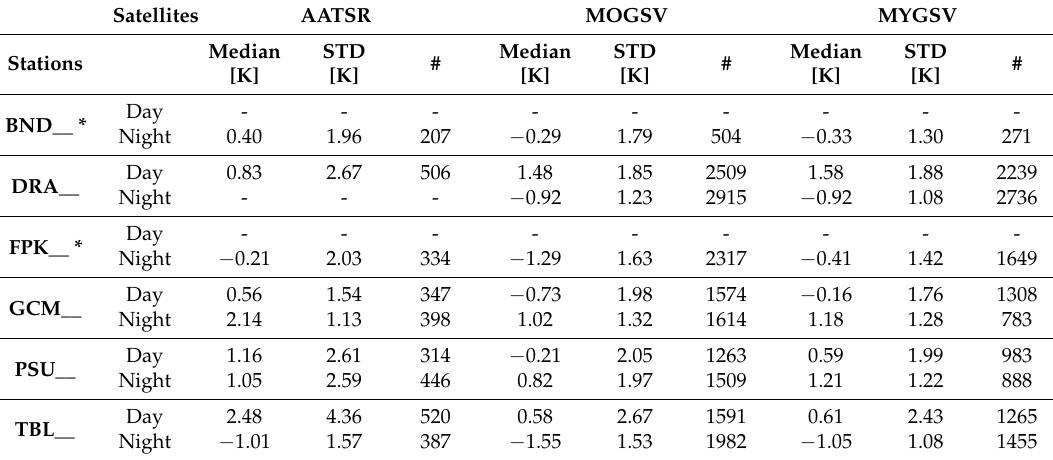
Table 5. Median validation accuracy, STD, and number of data points (#) over the SURFRAD stations for all satellites for the years